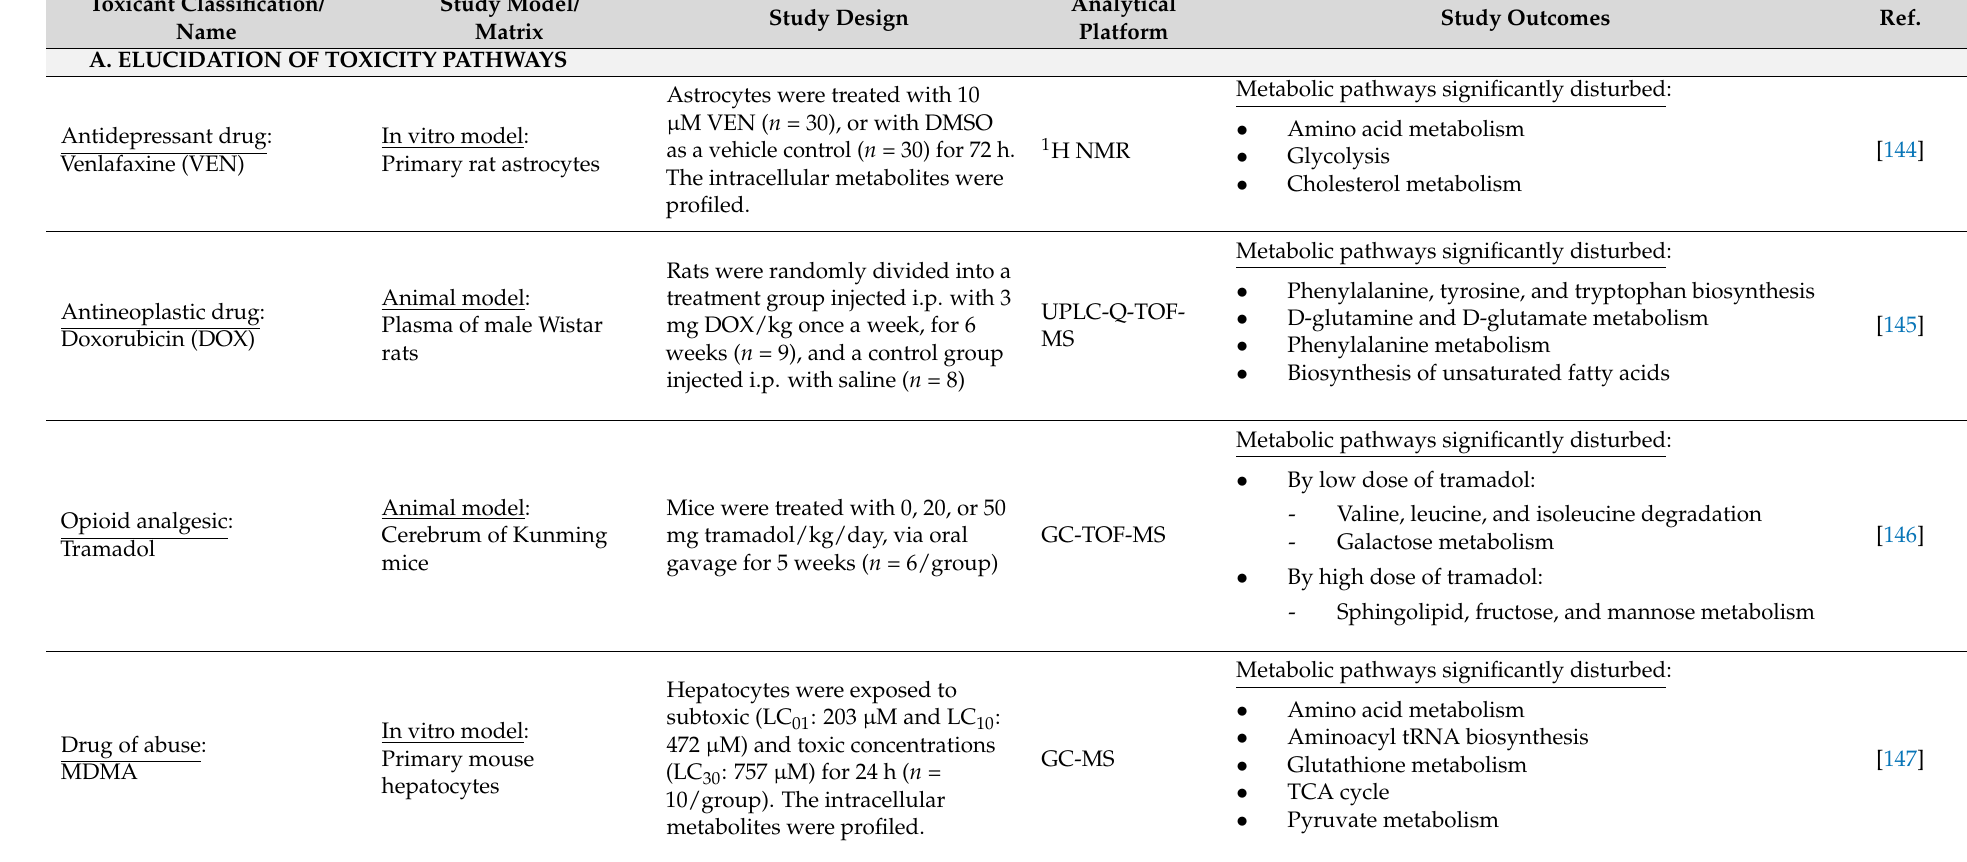
Table 3. Representative examples of recent studies using metabolomics in toxicological